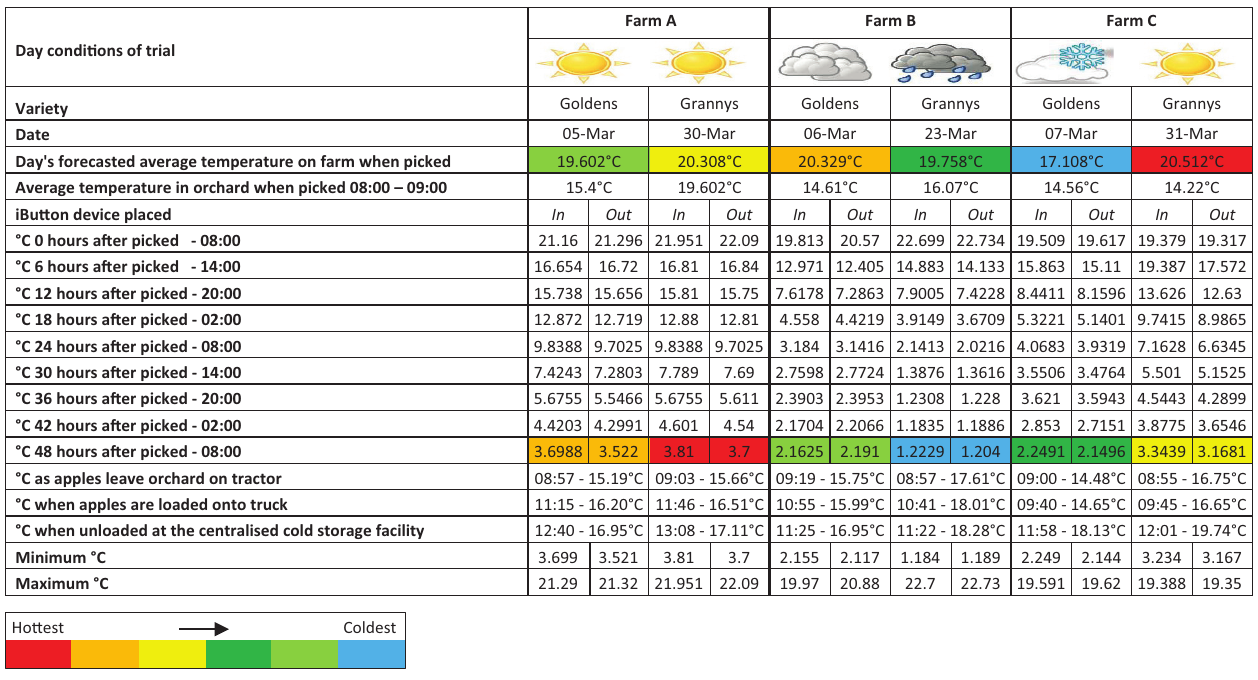
FIGURE 2: Weather information for Farm A, Farm B and Farm C on picking day.